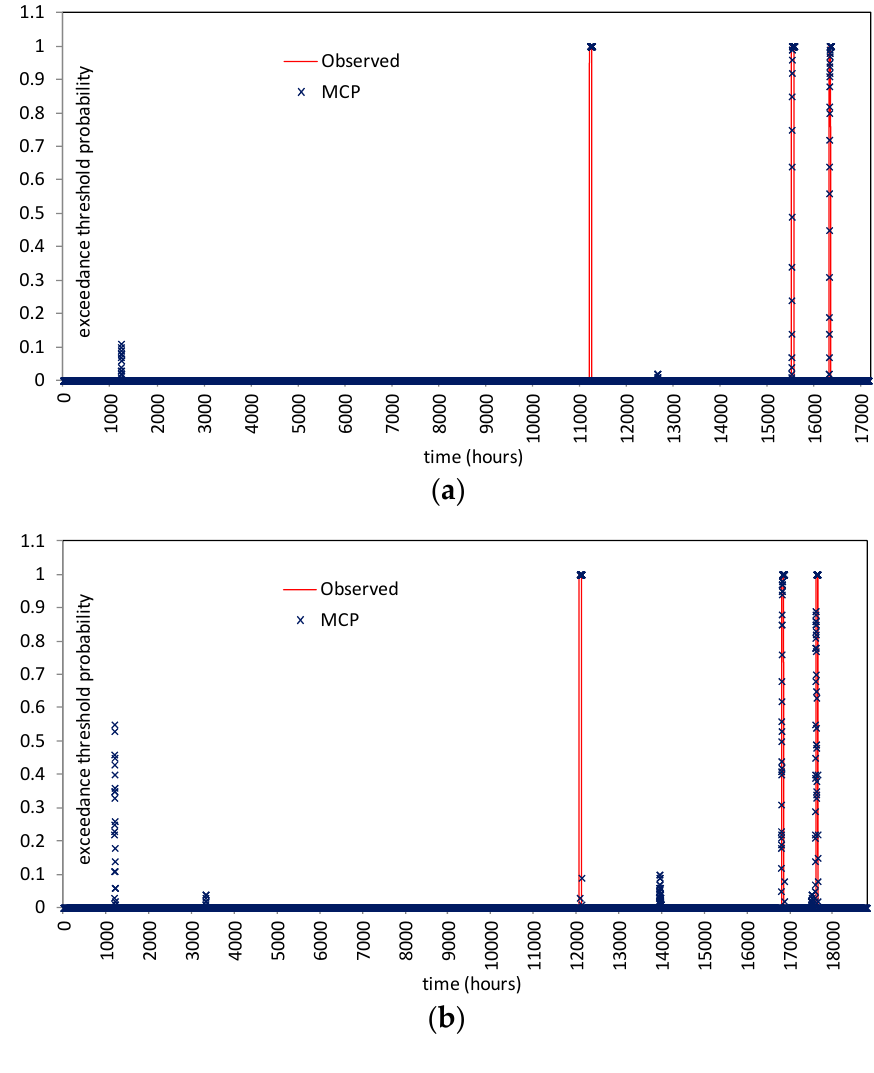
Figure 11. Polavaram section (lead ‐ time 24 h): overtopping warning threshold exceedance probability within the following 24 h estimated by MCP ‐ MT (the threshold exceedance probability at time t refers to the interval t – t + 24 h) for the flood occurred on: ( a ) 21–22 August 2001; and ( b ) 6–10 August 2010. The comparison between deterministic and probabilistic stage forecasts is also shown along with the observed occurrences.